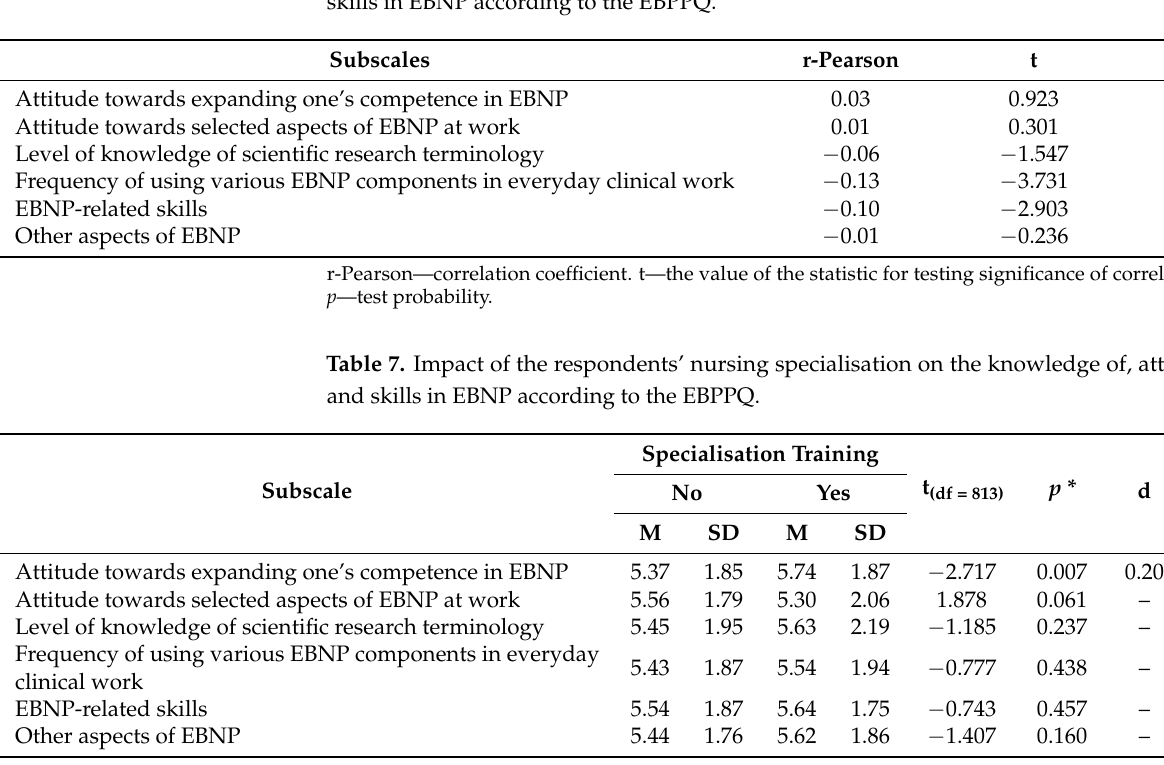
Table 6. Impact of the respondents’ work experience on the knowledge of, attitudes toward, and skills in EBNP according to the EBPPQ.